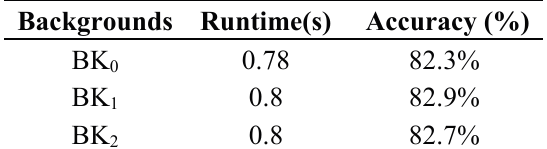
Table 3. Classification efficiency in different backgrounds.